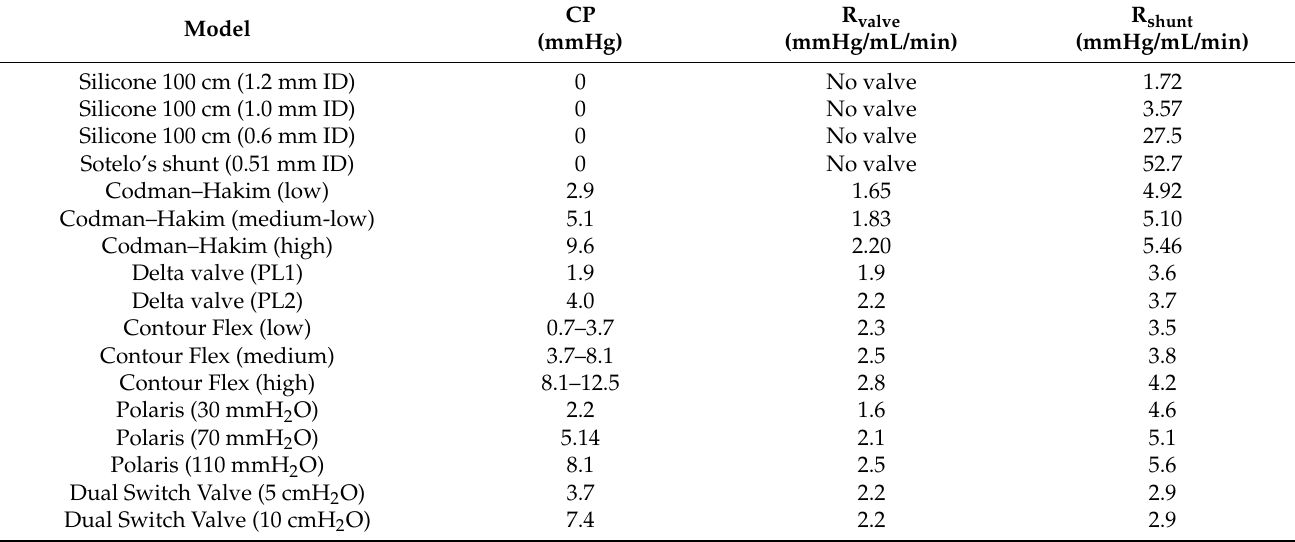
Table 1. The information shown in this table regarding resistance was extracted from different papers and reports published by the UK Shunt Evaluation Laboratory and not from the information provided by manufacturers [53]. When not available from independent studies, CP reflects the manufacturer information. Sotelo’s shunt data are from Sotelo et al. [51,58]. The hydrodymanic profiles of silicone tubes are calculated with the online calculator provided by vCalc™ (http://bit.ly/2Y9FEss, accessed on 1 September 2020) and considering that the viscosity of water at a temperature of 37 ◦ C is 0.69 mPa-s. CP: closing pressure in mmHg. R valve : static resistance of the valve calculated from pressure–volume tests and measured in mmHg/mL/min. R shunt : total resistance of the shunt as provided by the manufacturer that includes the R valve and the distal catheter provided by the manufacturer attached. Delta valve (Medtronic Medical Devices, Minneapolis, MN, USA) have two performance levels (PL1 and PL2) [59]. The values refer to the R valve without the siphon-controlled device